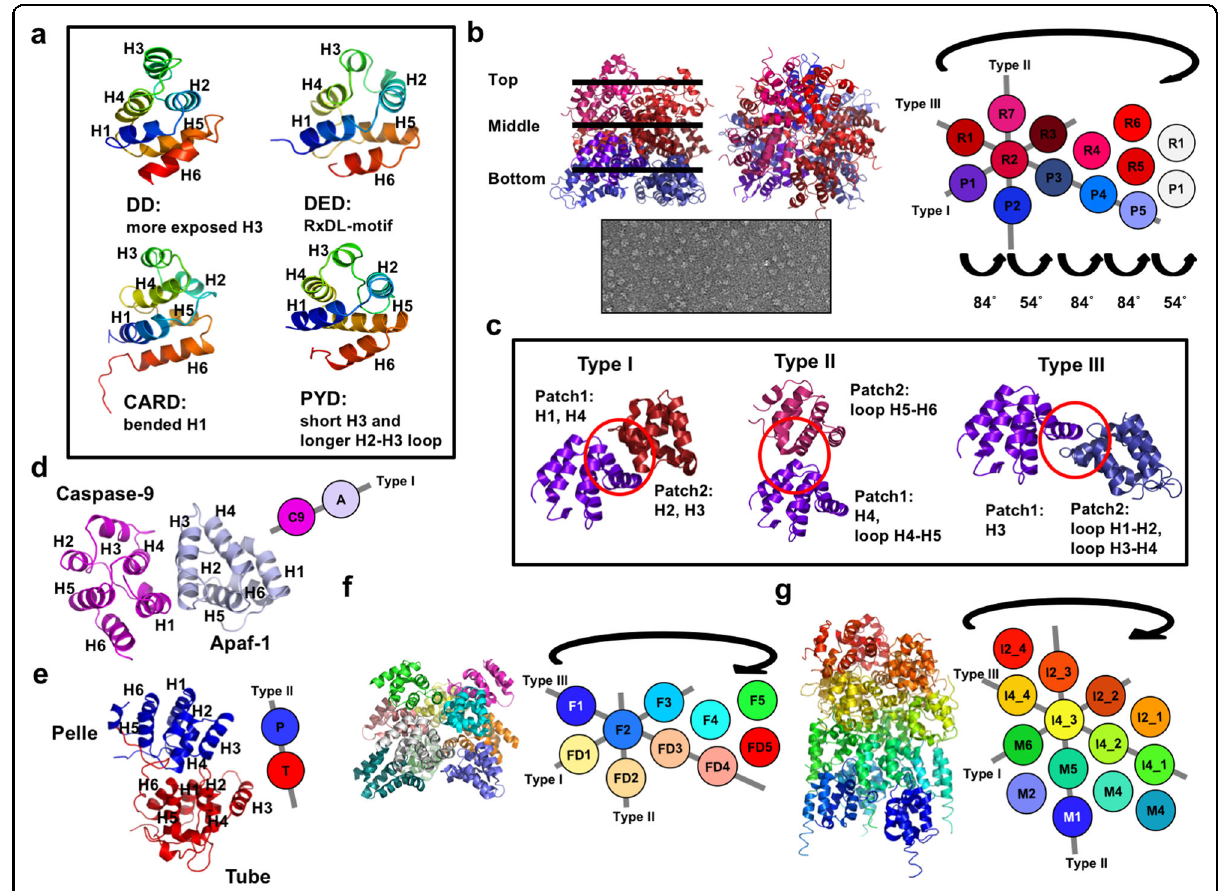
Fig. 1 Structure of the death domain (DD) superfamily and its prototype assembly scheme. a The structural features of DD superfamily members. Ribbon diagrams for each subfamily in the DD superfamily are shown. Representative structures are provided showing the Fas death domain as the DD, the FADD death effector domain (DED) as the DED, the RAIDD caspase recruitment domain (CARD) as the CARD, and the NLRP3 pyrin domain (PYD) as the PYD. The distinct structural features of each superfamily are indicated. The structures in the N-terminus to the C-terminus are colored blue and red, respectively. Secondary structures, H1 − H6, are indicated on the corresponding structure. b The fi rst helical structure discovered in the DD superfamily. The helical assembly is formed by a heteromeric complex of RAIDD DD and PIDD DD. Top and side views of the helical structure are shown in the upper left panel. Electron microscopy image of the negatively stained RAIDD DD/PIDD DD complex is presented in the lower left panel. The bottom layer formed by fi ve PIDD DDs, the middle layer formed by fi ve RAIDD DDs, and the top layer formed by two RAIDD DDs are indicated in the side view of the complex structure. A schematic planar diagram showing the strategy for the helical assembly by successive screw rotations with up and down interactions in a hypothetical PR subcomplex is shown in the right panel; P and R indicate PIDD DD and RAIDD DD, respectively. c The three different interaction prototypes, types I, II, and III, formed by DD superfamily members. The interaction interface is shown with a red circle. The helixes and loops involved in the interaction are indicated. d Prototype of the heterodimeric structure of the DD superfamily formed by caspase-9 CARD and Apaf-1 CARD. Secondary structures, H1 − H6, are indicated on the corresponding structure. This heterodimer is formed by type I interactions. e Prototype of the homodimeric structure of the DD superfamily formed by Pelle DD and Tube DD. Secondary structures, H1 − H6, are indicated on the corresponding structure. This heterodimer is formed by type II interactions. f , g Other cases of helical assembly by DD superfamily members. f Representative helical structures formed by heteromeric Fas DD and FADD DD and g by heteromeric IRAK2 DD, IRAK4 DD, and MyD88 DD are shown. Schematic planar diagrams are presented to show binding strategy information; F and FD P indicate Fas DD and FADD DD, respectively; I2, I4, and M indicate IRAK2 DD, IRAK4 DD, and MyD88 DD,